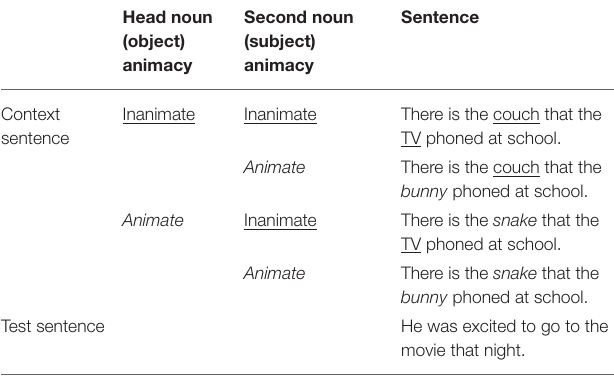
Frontiers in Communication |